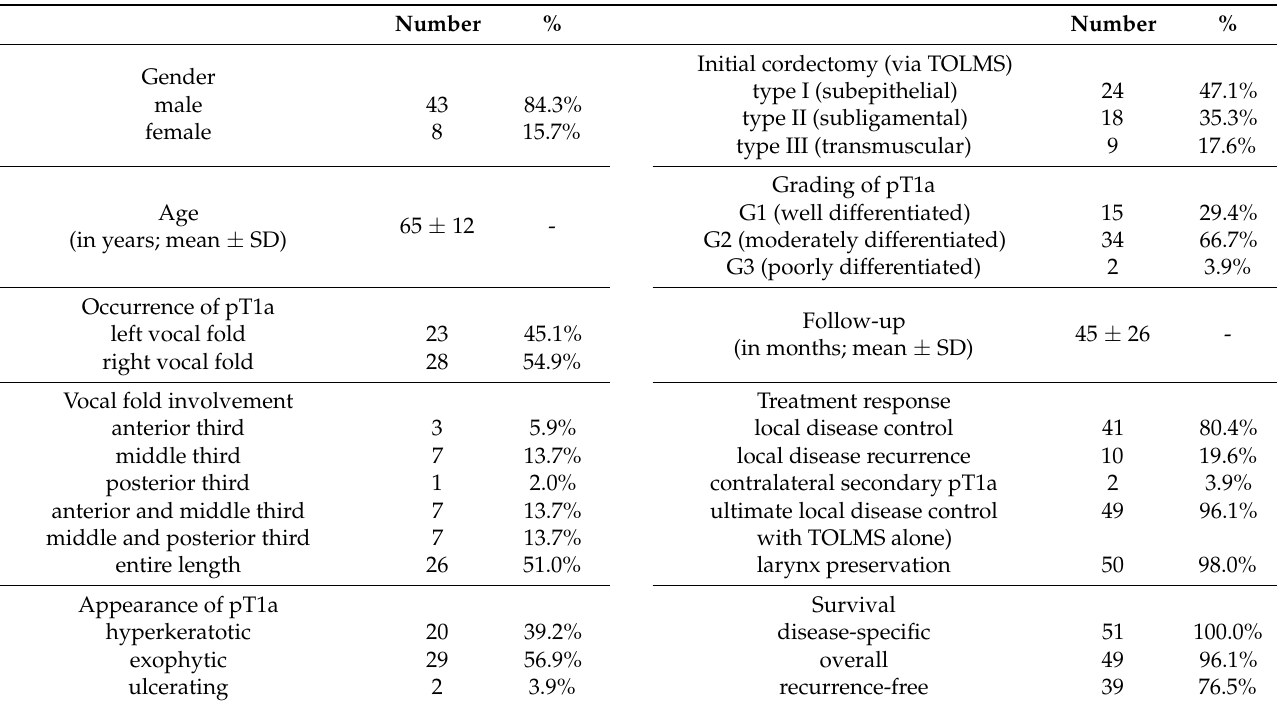
Table 1. Patient characteristics ( n = 51) before TOLMS (left) and after TOLMS (right). Unless otherwise specified, data expressed as number of patients and percentage of